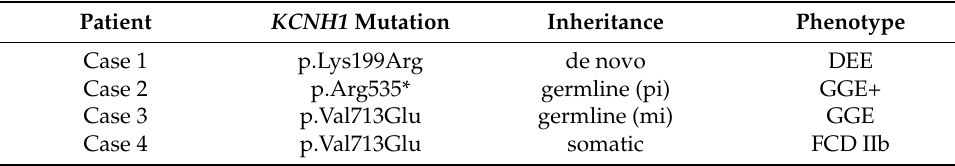
Table 1. Overview of novel KCNH1 mutations detected in this study.